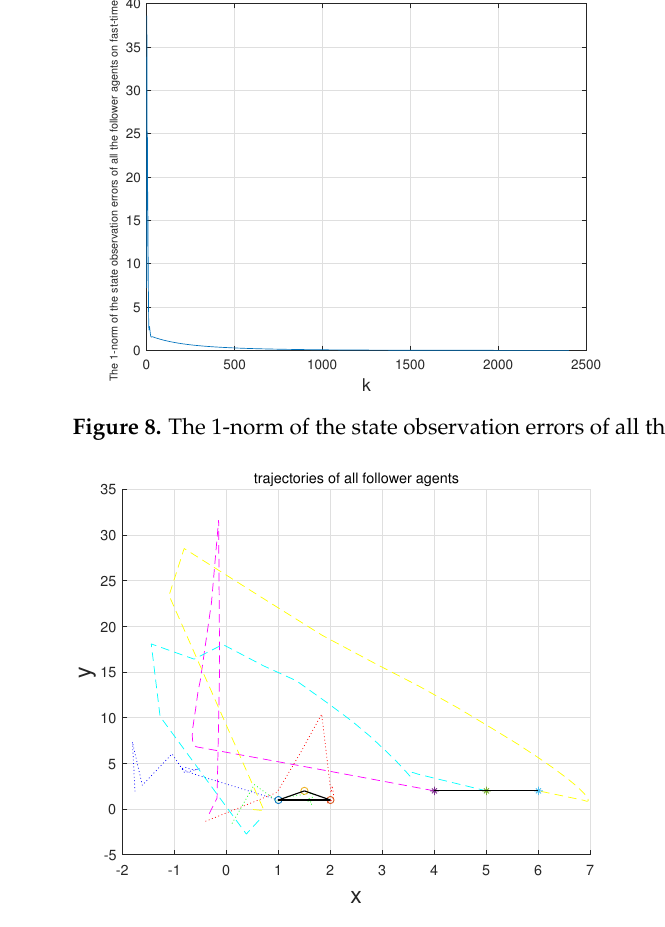
Figure 9. Trajectories of all follower